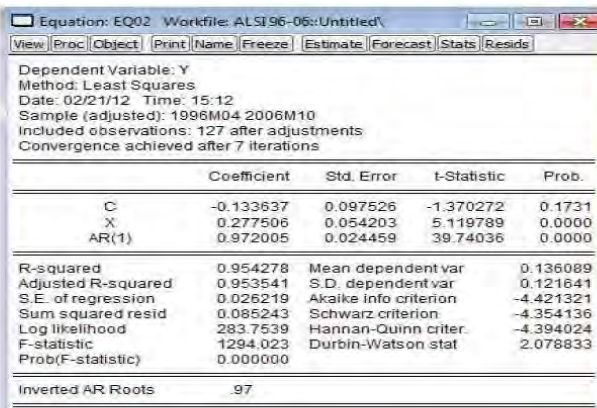
Table 1: All-Cap OLS estimation ou1put, Mar96- Oct06